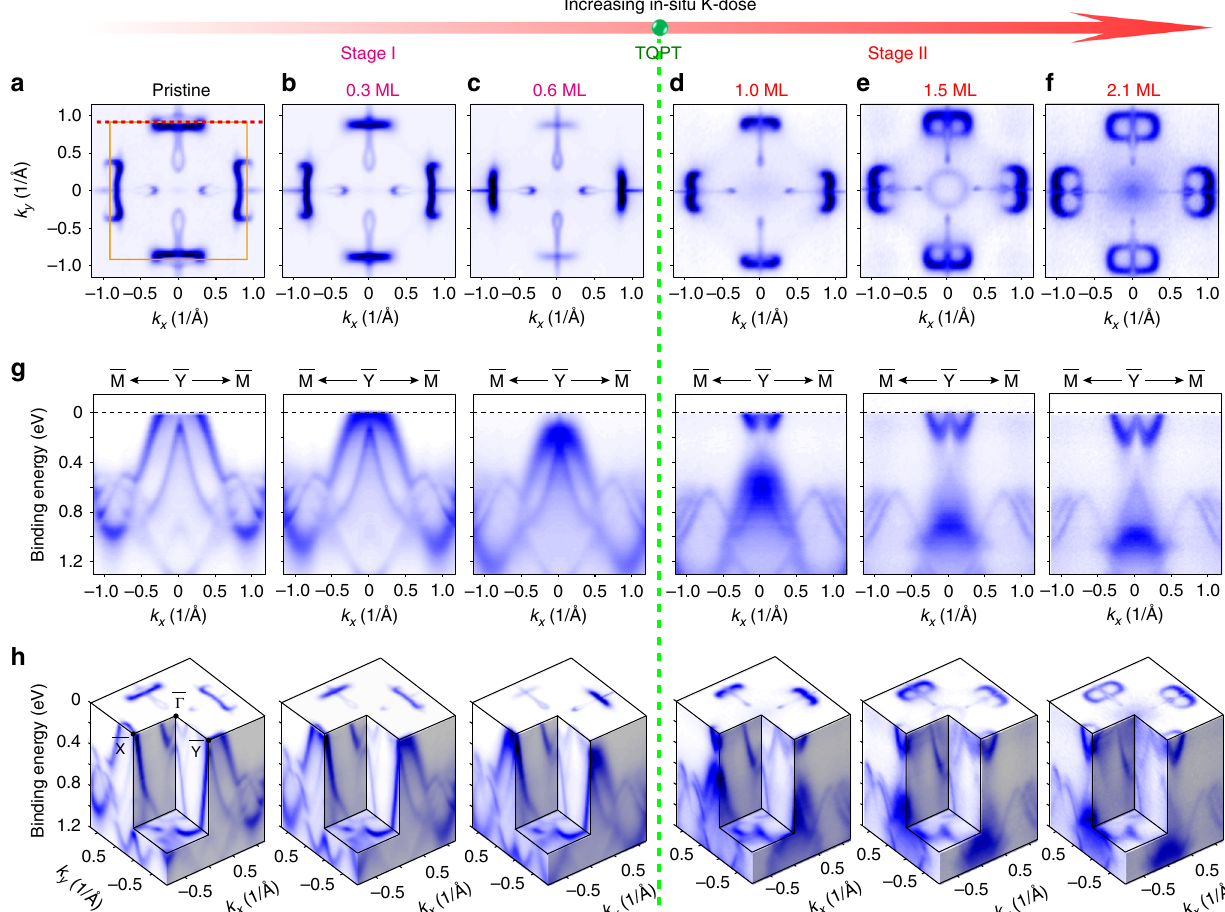
Fig. 5 Detailed band structure evolution of topological Lifshitz transition of SFAs. a – f , g , and h are the evolution of the FS, representative band dispersion along the M - Y - M direction, and 3D intensity plot of the overall band structure with progressively increasing the K dose, respectively. For comparison, these contours are obtained by mirroring the photoemission spectrum with respect to the k y axis. The overall evolution consists of two stages: Stage I is from Panel a to Panel c , and Stage II is from Panel d to Panel f . Between these two stages, a surface topological quantum Lifshitz transition (TPLT) occurs. We note that the uneven intensity of the FS between the fi rst and second BZs are due to the photoemission matrix element effect